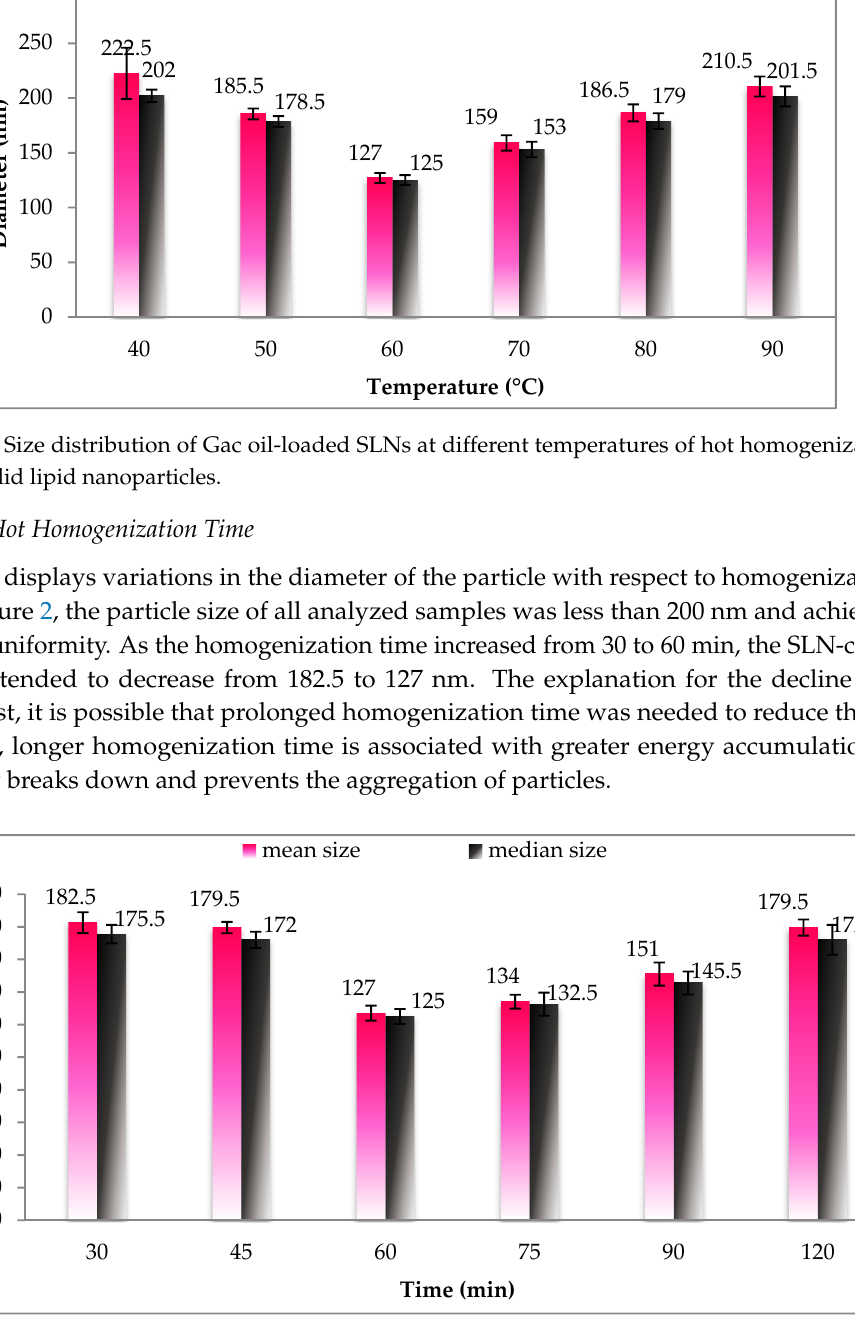
Figure 2. Size distribution of gac oil-loaded SLNs at different times of hot homogenization.